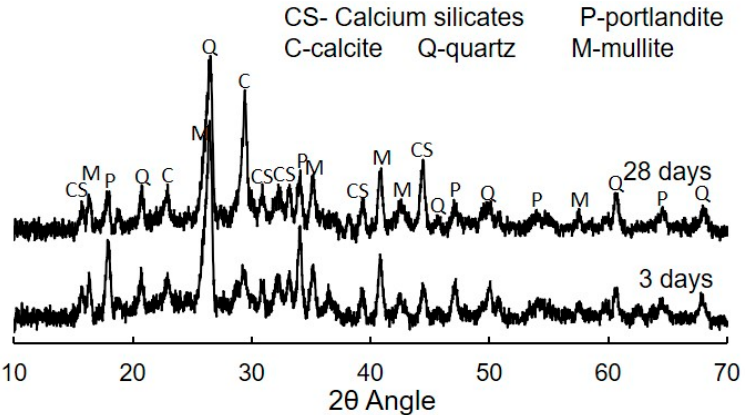
Figure 9. XRD spectra of the NM mix at 3 days and 28 days.